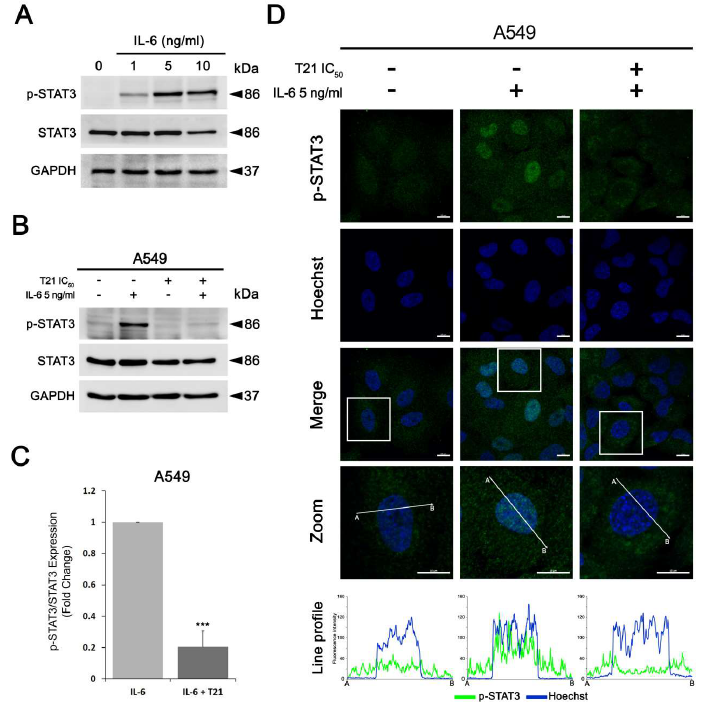
Figure 5. T21 blocks STAT3 activity after IL-6 stimulation. ( A ) A549 cells were starved, then treated with different concentrations of IL-6 and phosphorylation levels of STAT3 were assessed by Western blot analysis. ( B ) and ( C ) after starvation, A549 were pretreated with IC 50 T21 for 4 h followed by 5 ng/mL of IL-6 stimulation for 30 min. Phosphorylation levels of STAT3 were then assessed by Western blot analysis. Bars represent the mean ± SD. Statistically significant results are indicated as *, p -value < 0.05; **, p -value < 0.01 and ***, p -value < 0.001. ( D ) A549 cells were pretreated with IC 50 T21 for 4 h, after starvation, followed by 5 ng/mL of IL-6 stimulation for 30 min. Subcellular localization of phospho-STAT3 (Y705) was assessed by immunofluorescence staining. The framed regions are zoomed in the bottom images. The line profiles of phospho-STAT3 (Y705) and Hoechst signals were measured by ZEN 2.3 blue edition (Carl Zeiss) software. (Scale bars correspond to 10 µ